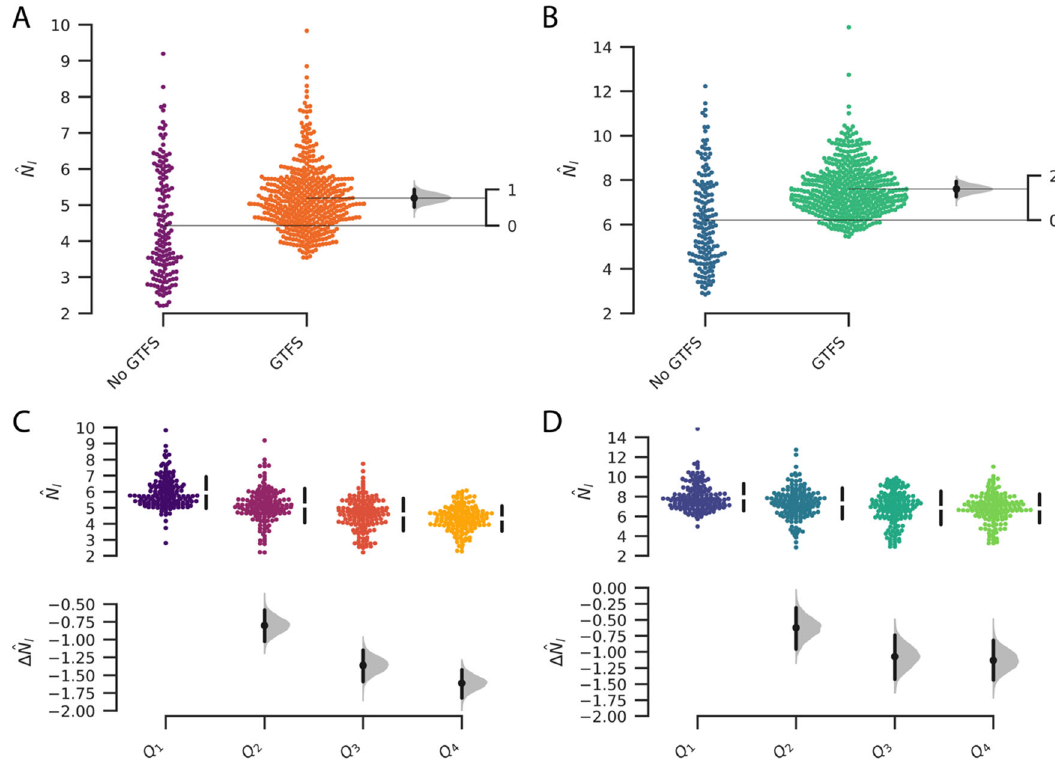
Fig. 3 How gender differences in mobility correlate with access to public transport and socioeconomic status. Top: estimation plots of the difference in the number of locations visited by women ( a ) and men ( b ). where each dot is a cell classi fi ed according to having access to public transport (GTFS) or not (No GTFS). Bottom: estimation plots of the difference in the number of locations visited by women ( c ) and men ( d ) where each dot is a cell ranked by quartile of GSE ratio. Each group represents cells in decreasing quartiles of income, from the top to the bottom